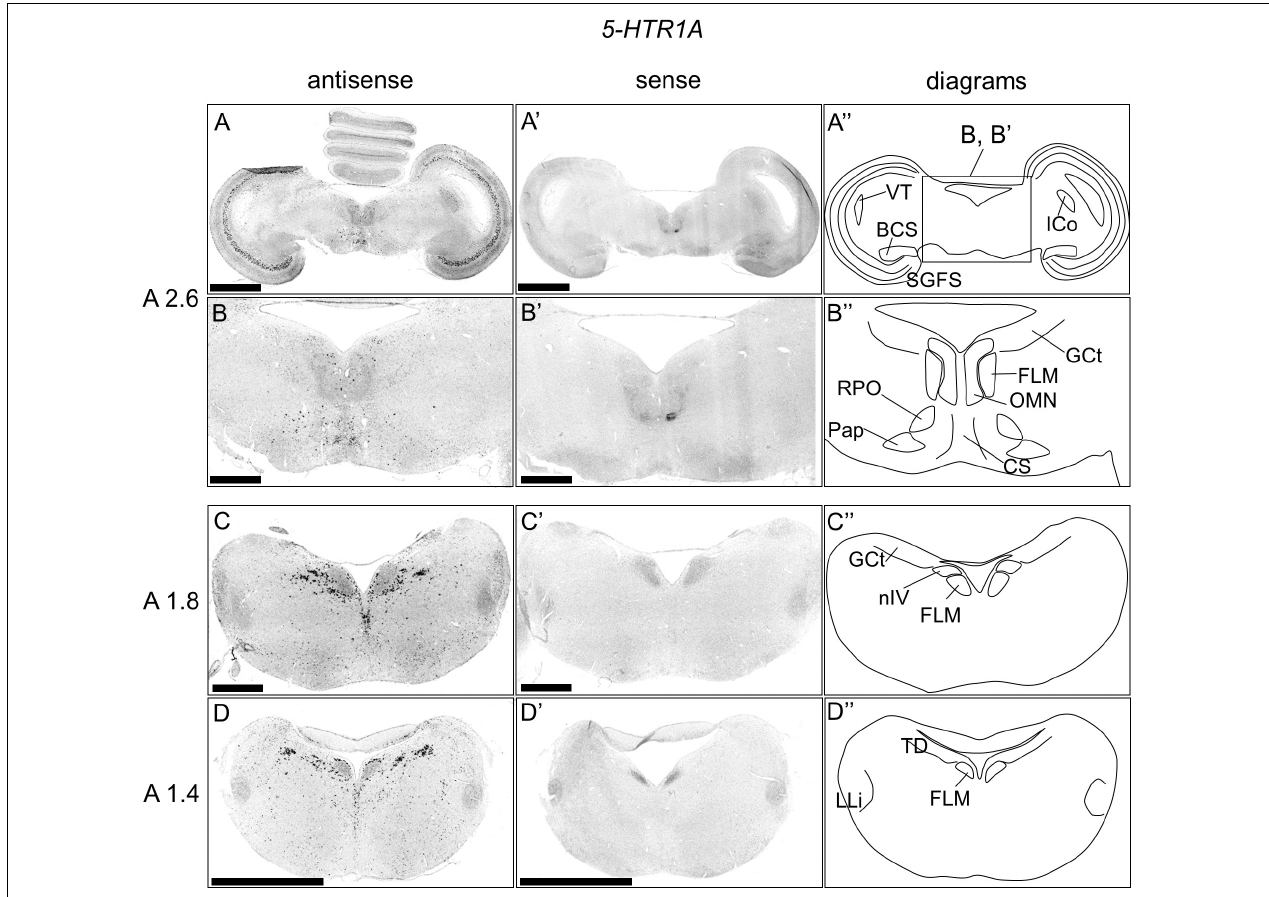
FIGURE 2 | In situ hybridization of 5-HTR1A in the P1 chick brainstems. Digoxigenin-labeled RNA antisense (A–D) and sense (A’–D’) 5-HTR1A probes were used for in situ hybridization in coronal sections of P1 chick brains. To evaluate the expression patterns of 5-HTR1A , sections of four chicks were analyzed, and representative images of two chick brain sections are shown. (B,B’) Magnified views of brain areas in the box in panel (A”) are shown. (A”–D”) Diagrams of coronal sections are shown in the rightmost panels. The levels of the sections (A 2.6, A 1.8, and A 1.4) are in accordance with those mentioned in Kuenzel and Masson’s chick atlas (Kuenzel and Masson, 1988). BCS, brachium colliculi superiors; CS, nucleus centralis superior; FLM, fasciculus longitudinalis medialis; GCt, griseum centrale; ICo, nucleus intercolicularis; LLi, nucleus ventralis lemnisci lateralis; nIV, nucleus nervi trochlearis; OMN, oculomotor nucleus; Pap, nucleus papillioformis; RPO, nucleus reticularis pontis oralis; SGC, stratum griseum centrale; TD, nucleus tegmenti dorsalis; VT, ventriculus tecti mesencephali; P1, post-hatch day 1. Scale bars = 2.5 mm (A,D,A’,D’) and 1 mm (B,C,B’,C’) .